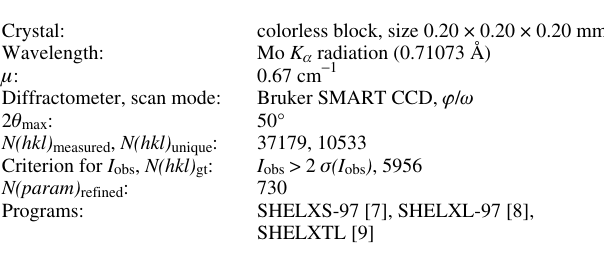
Table 1. Data collection and handling.